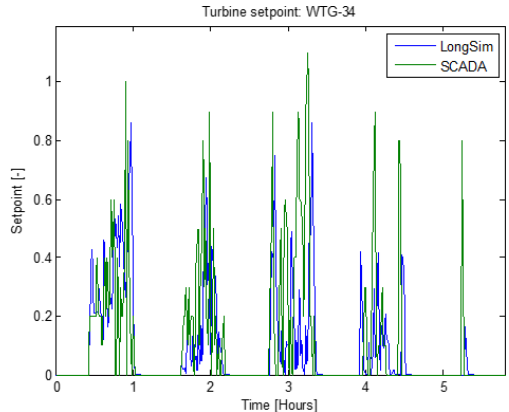
Figure 14. Measured and simulated setpoints at turbine no.